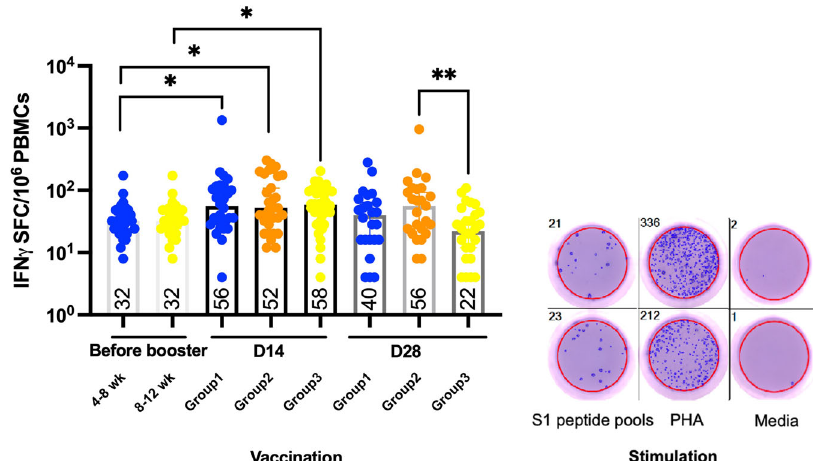
Fig. 5 T cell responses after the booster. All volunteers were previously vaccinated with two doses of inactivated SARS-CoV-2 vaccines. After 4 – 8 weeks (Group2) and 8 – 12 weeks (Group3), the fractional dose of a viral vector vaccine was delivered intradermally; as a booster dose.